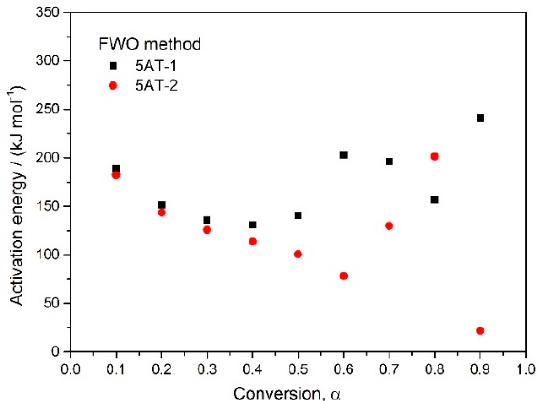
Figure 4. Comparison for E vs. α between 5AT–1 and 5AT–2 obtained using FR method.